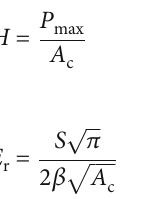
is the peak load, S is the contact sti ff ness, h is the indentation max